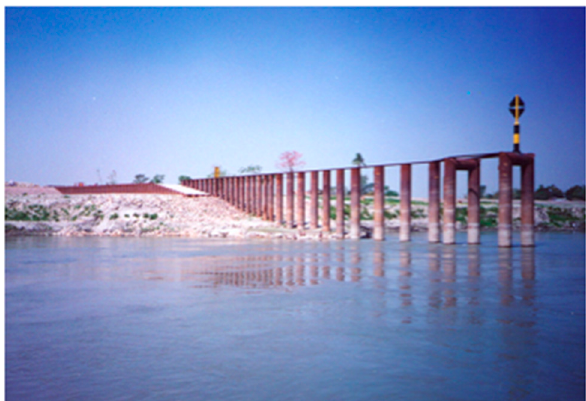
Figure 6. Kamarjani test site groyne G-1 consists of a 6-m-long steel sheet pile cofferdam protected by